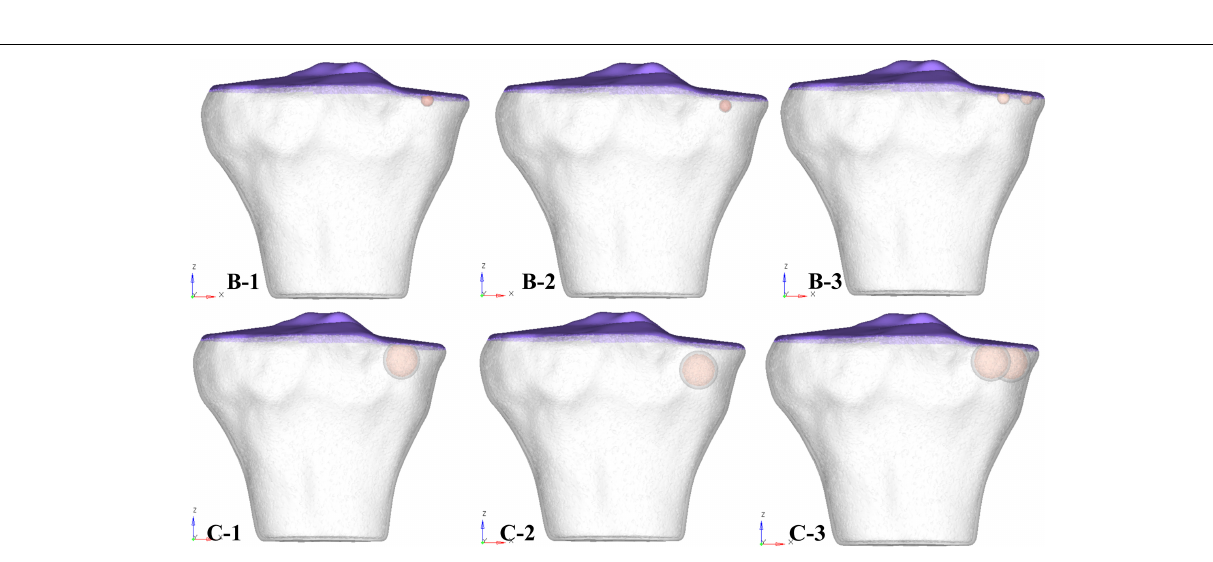
FIGURE 2 | 3D tibial plateau models showing size, number, and location of SBCs in three sub-groups of group B and group C. SBCs, subchondral bone cysts.